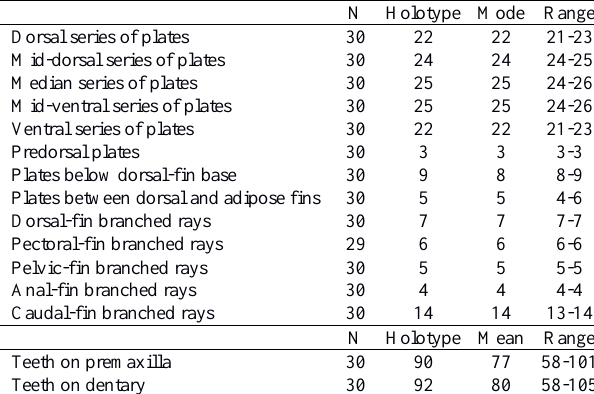
N Holotype Mode Range